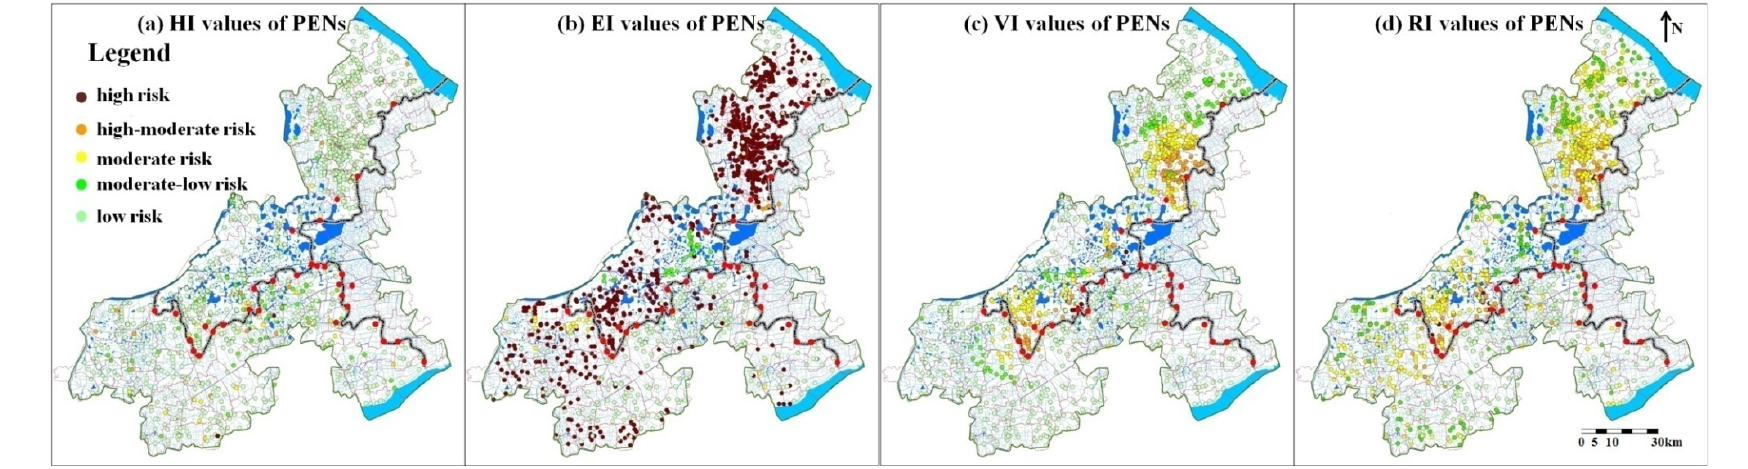
Figure 5. Spatial distribution of HI, EI, VI and RI values of the